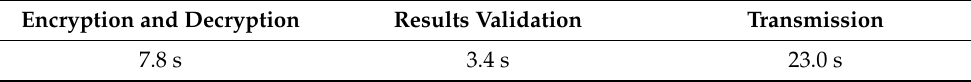
Table 6. Details about latency